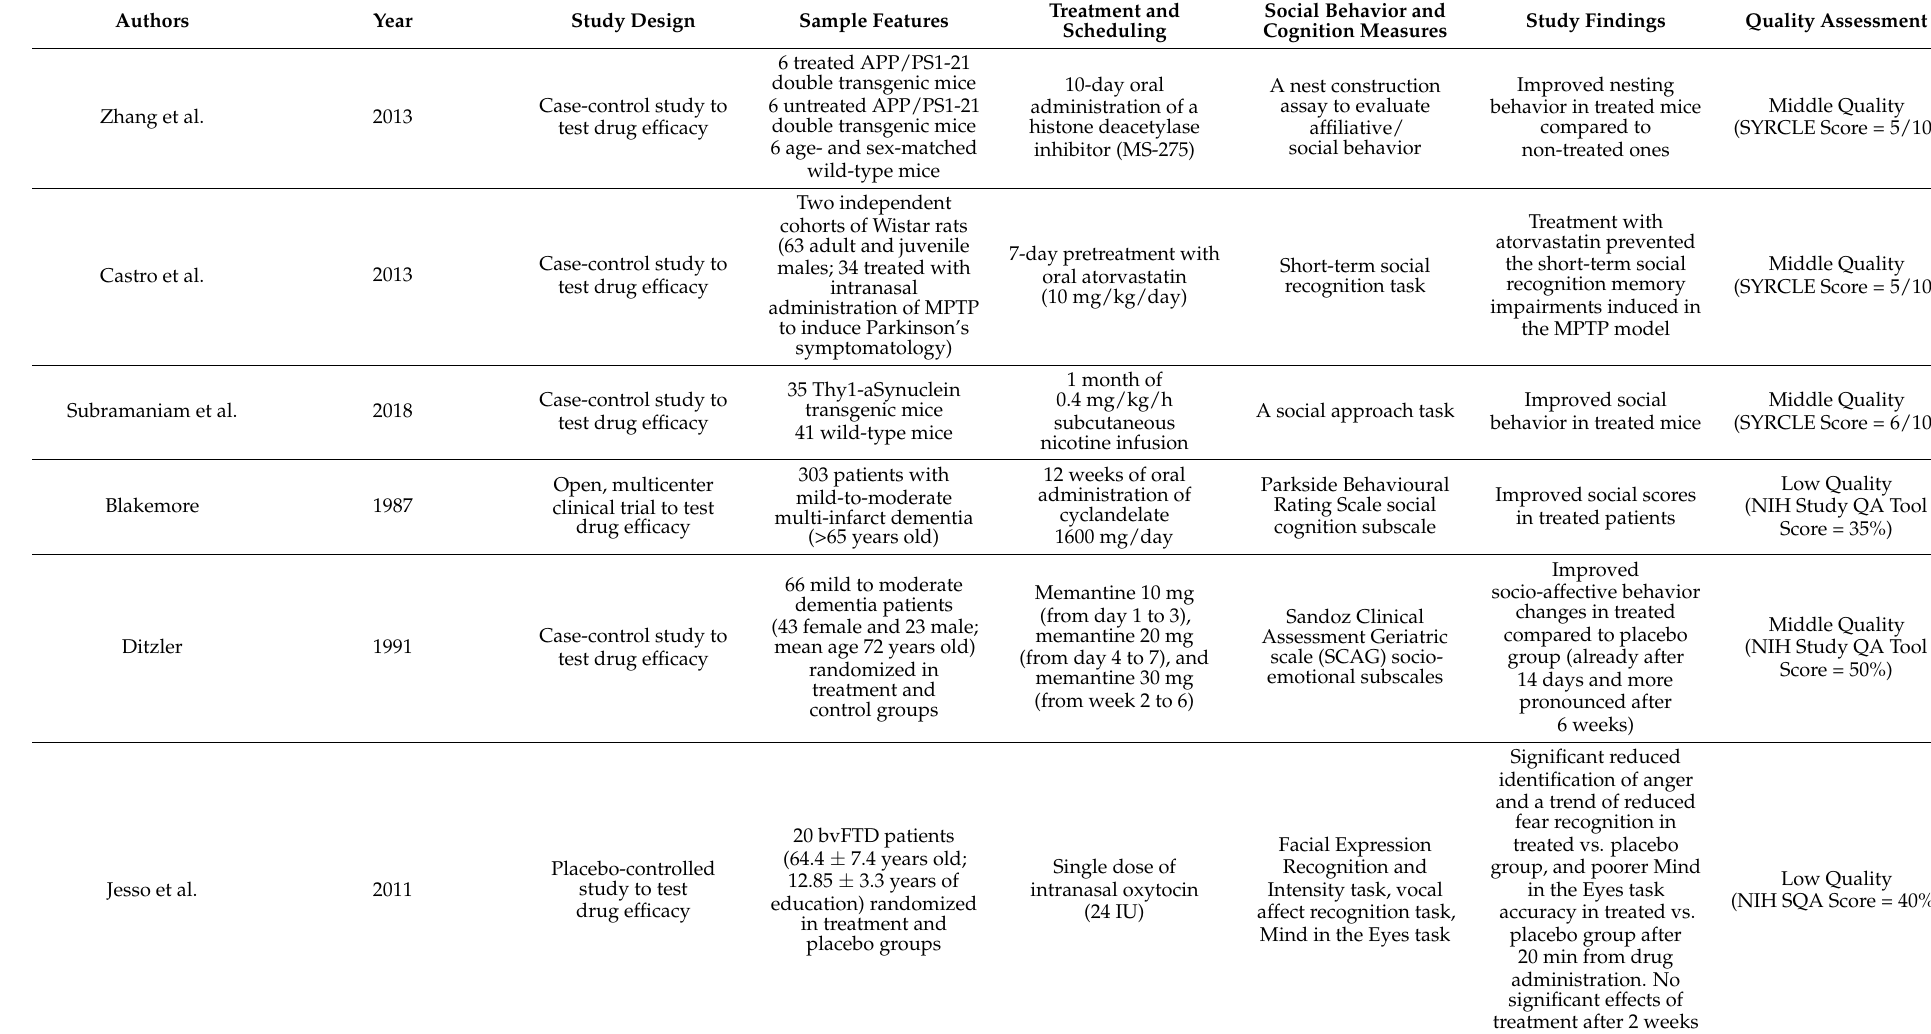
Table 1. Pharmacological treatment studies in animal models and neurocognitive